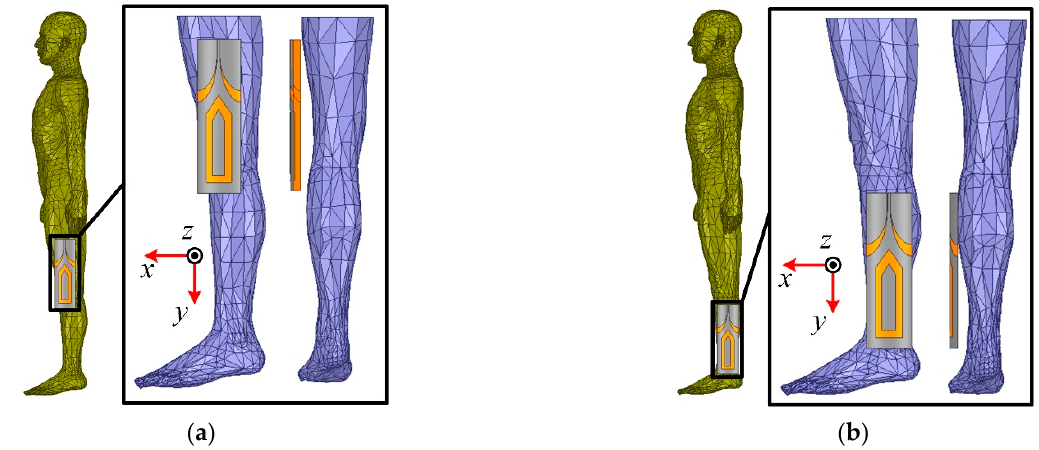
Figure 9. The wearable antenna loaded on the different positions of the voxel model. ( a ) Thigh area. ( b ) Shank